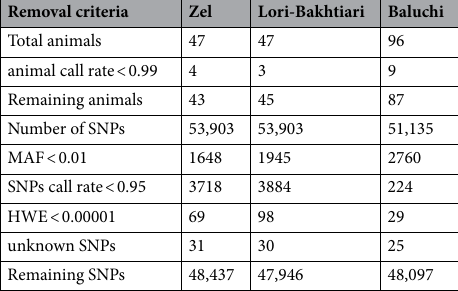
Table 1. Results of data quality control.